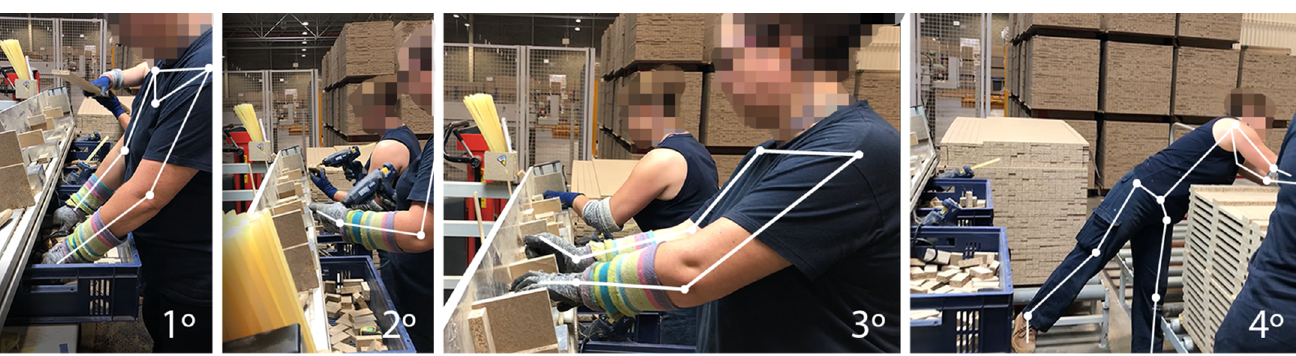
Figure 3. Workers postures during the assembly work cycle.